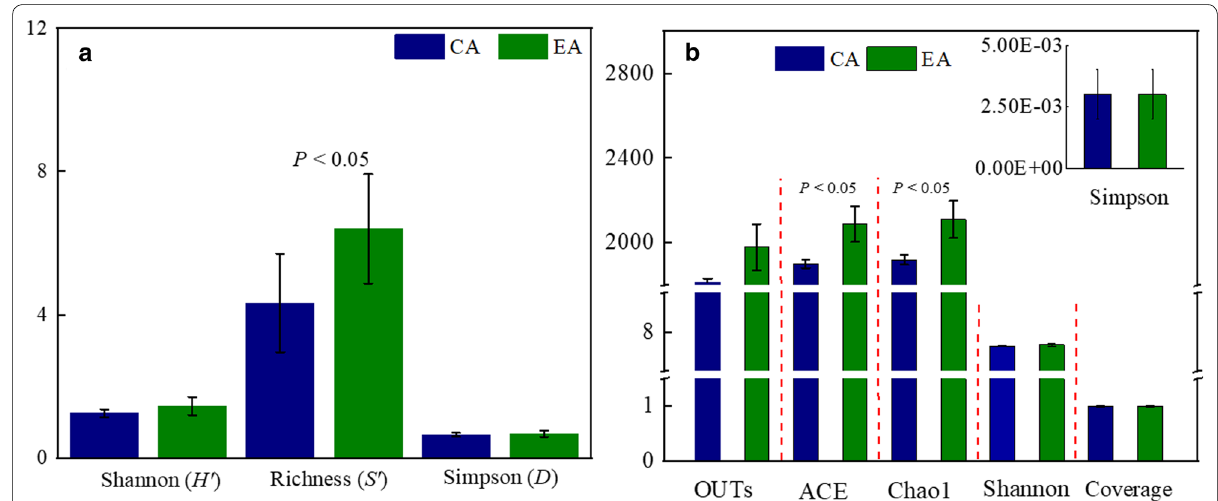
Fig. 3 Plant ( a ) and paddy soil ( b ) bacterial diversity between CA and EA. CA represents conventional agriculture, and ecological agriculture is abbreviated as